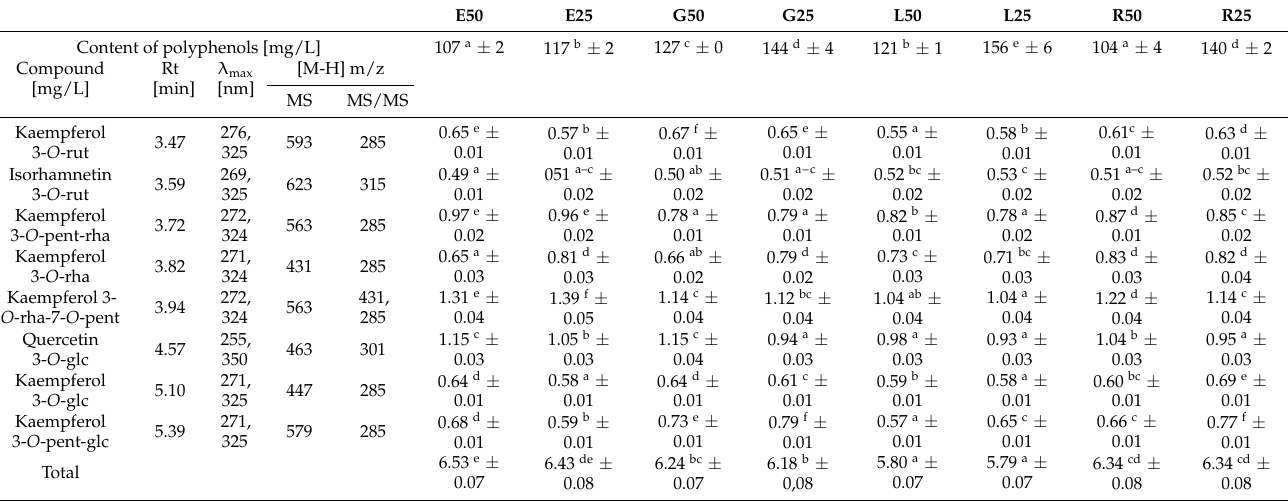
Table 3. Polyphenol and individual phenolic compounds identified by UPLC-PDA-MS/MS in Witbier-style beers.